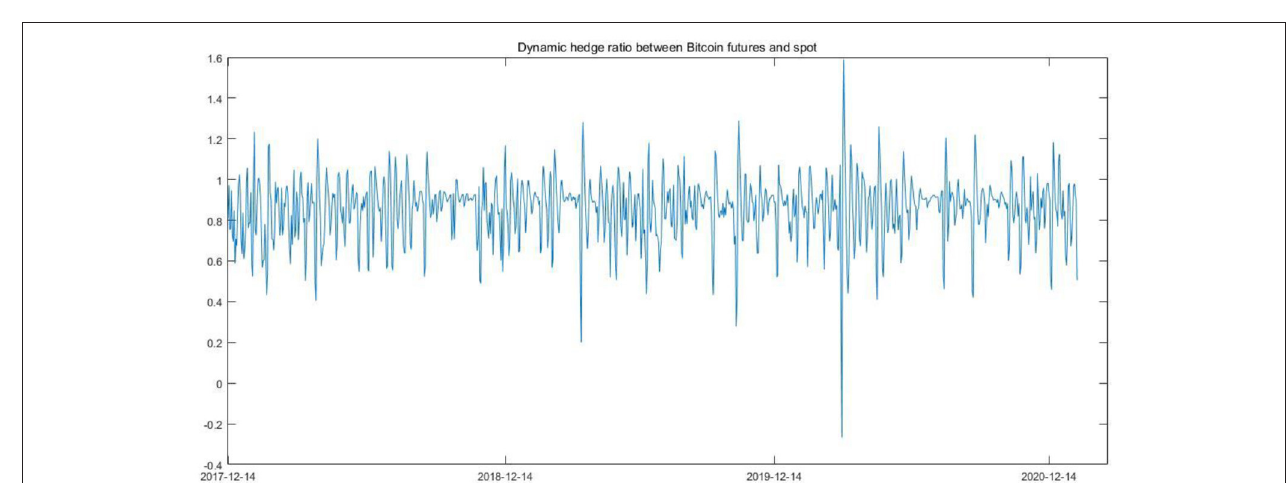
FIGURE 5 | Dynamic hedge ratio between Bitcoin futures and